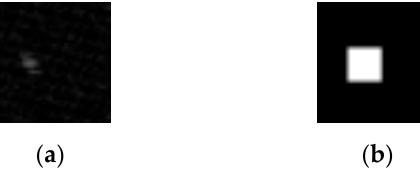
Figure 3. Calculation of transfer function for performing subpixel motion compensation. ( a ) The 2D transfer function of reference frame to target frame that contains noise due to false similarity. ( b ) The 9 × 9 2D rectangular window to pull out meaningful components of transfer function. ( c ) The filtered component of transfer function masked by the 9 × 9 mask.